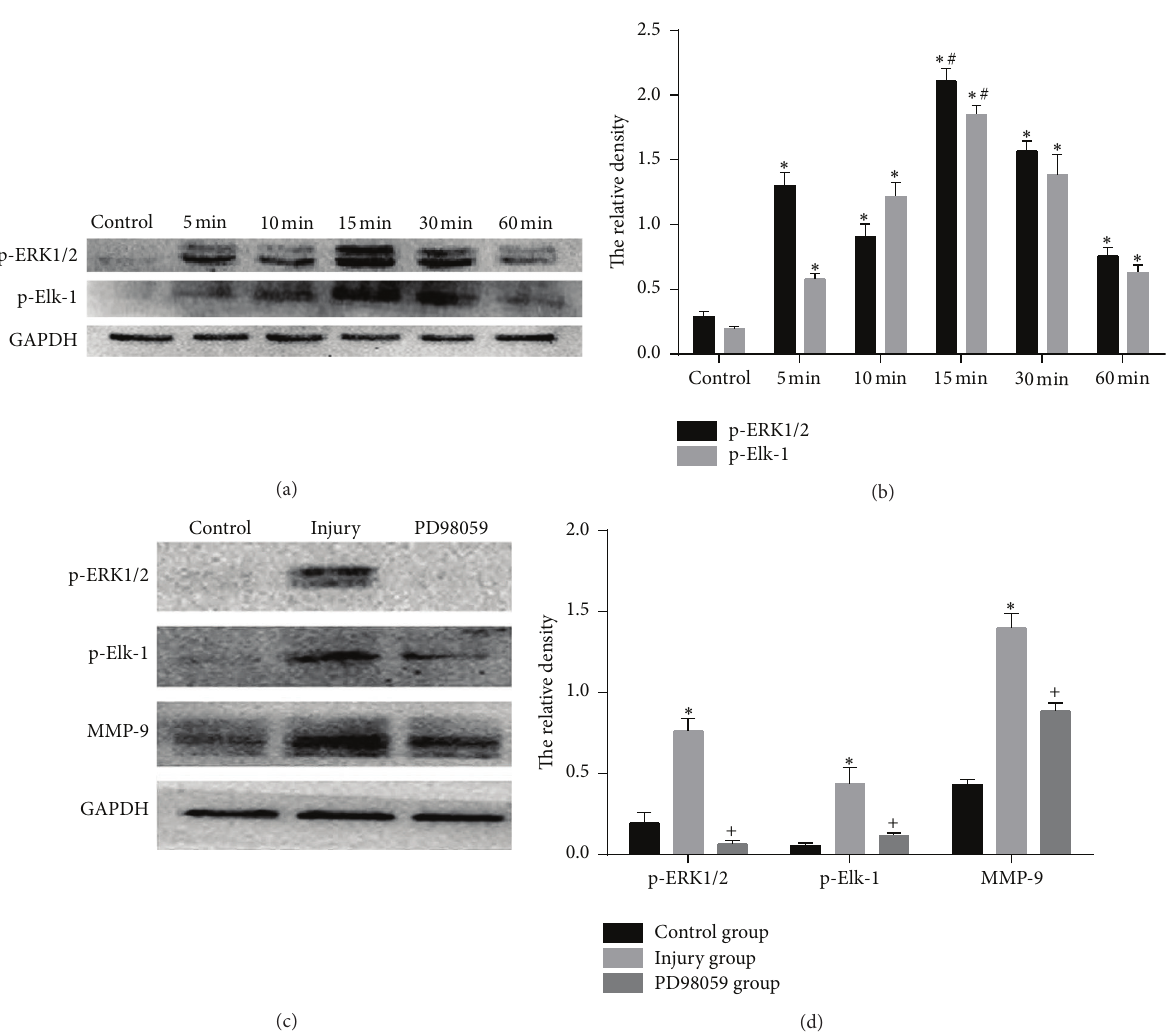
Figure 5: MMP-9 expression is modulated by the ERK1/2/Elk-1 pathway. (a) Phosphorylation of ERK1/2 and Elk-1 protein in control cultures of THP-1 cells and in cultures treated with the supernatants of scratch-injured human umbilical vein endothelial cells (HUVECs) for 5, 10, 15, 30, and 60 min. (b) Quantitative data for (a). (c) Phosphorylation of ERK1/2 and Elk-1 and expression of MMP-9 protein in control group, injury group, and PD98059 group. Control group was THP-1 cultures treated with the supernatants of HUVECs without scratch injury, while injury and PD98059 groups were cultures treated with supernatants of scratch-injured HUVECs for 6 hours. Cultures of the PD98059 group were pretreated with PD98095 for 1 h prior to HUVEC supernatants treatment. (d) Quantitative data for (c). ∗ 𝑃 < 0.05 compared with control group; # 𝑃 < 0.05 compared with rest groups; + 𝑃 < 0.05 compared with injury